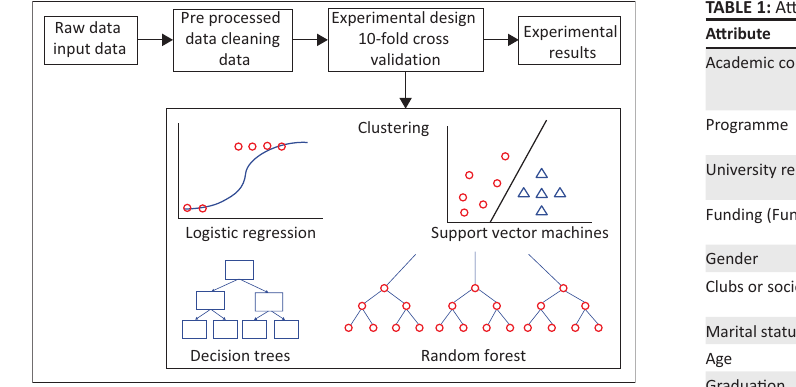
FIGURE 3: Clustering and classification of students’ data